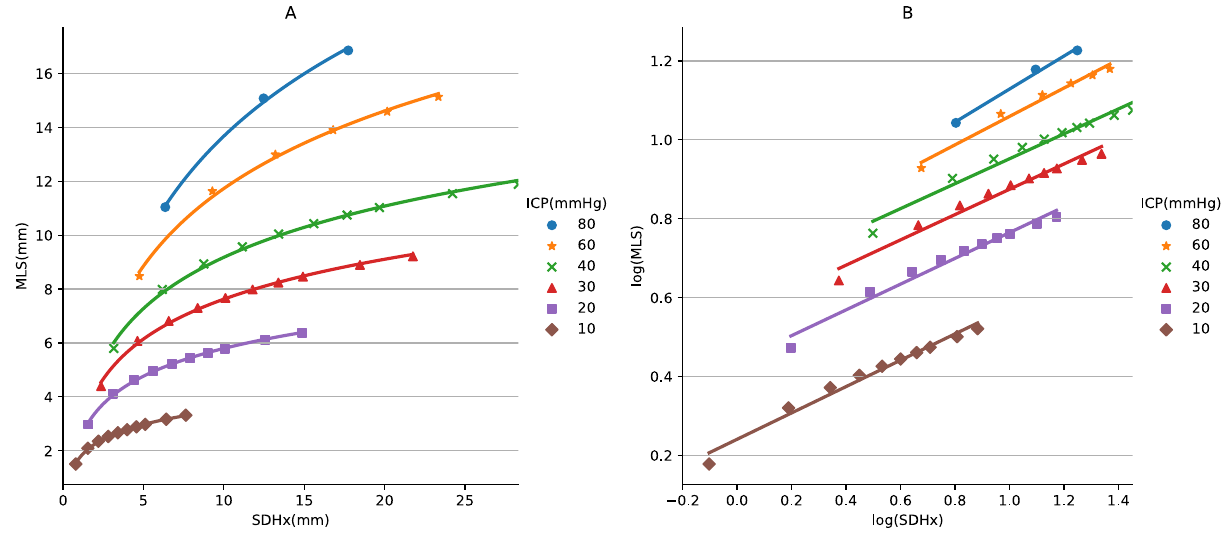
Figure 1. Scatter plots of simulated midline shift (MLS) against subdural hematoma thickness (SDHx) under different intracranial pressures (ICPs in mmHg) listed in legends, in linear ( A ), and in logarithmic scales ( B ). Units of SDHx and MLS in mm. Trend lines are generated from logarithmic ( A ) and linear ( B ) regressions using data points with the same